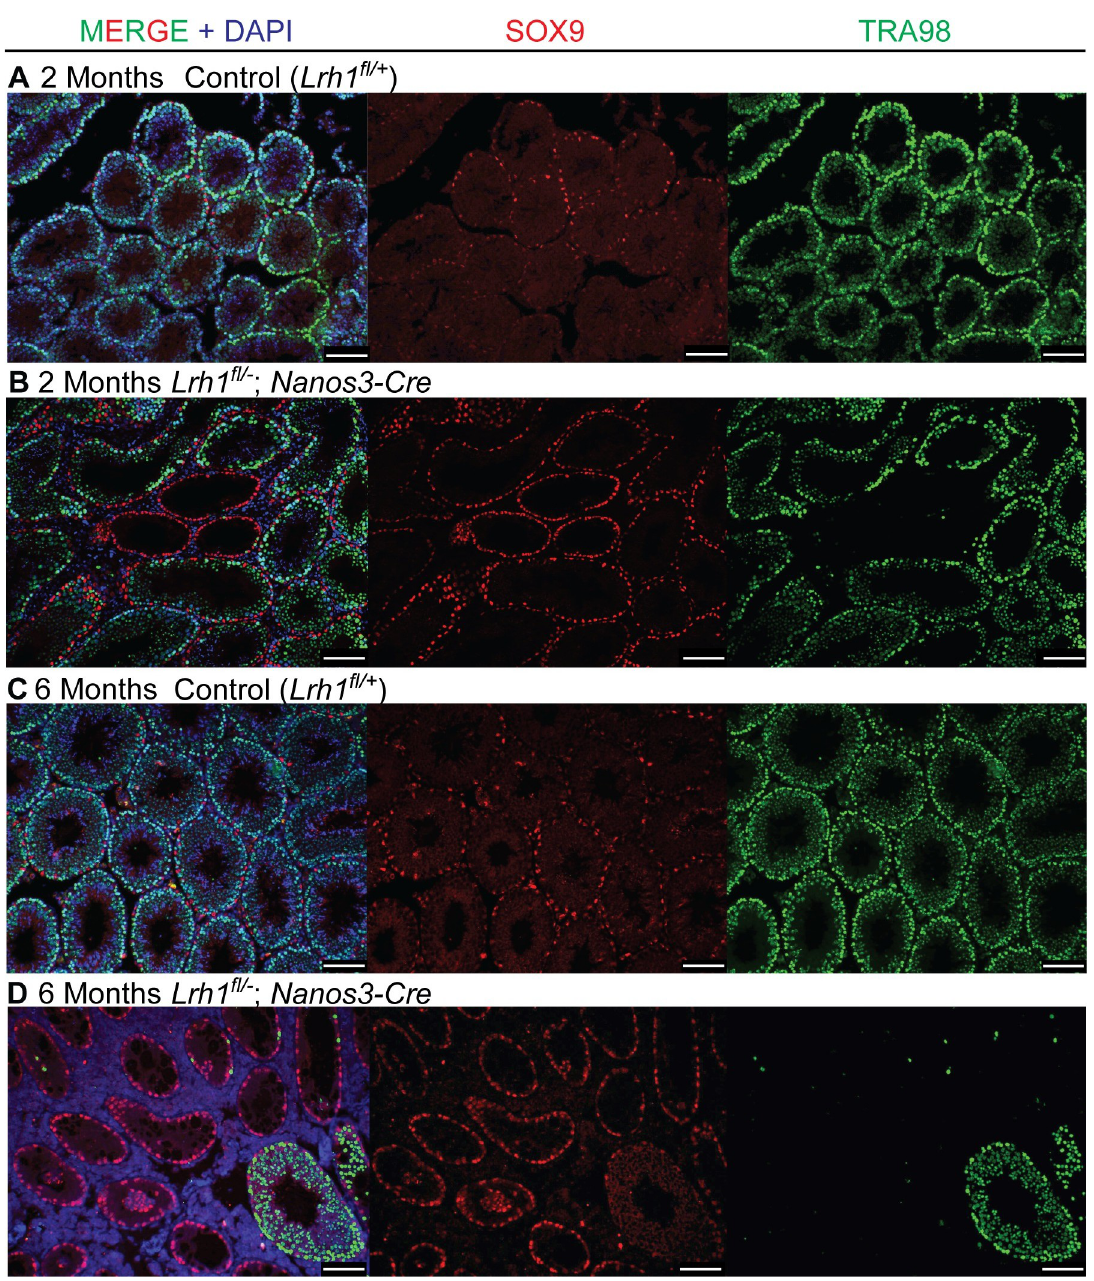
Fig 11. Loss of Lrh1 in germ cells causes progressive loss of spermatogenesis. IF of sections from control or germ cell-specific Nanos3-Cre Lrh1 mutant testes stained for SOX9 (red), TRA98 (green) and DAPI (blue) at 2 months (A,B) and 6 months (C,D). Scale bars: 100 um.